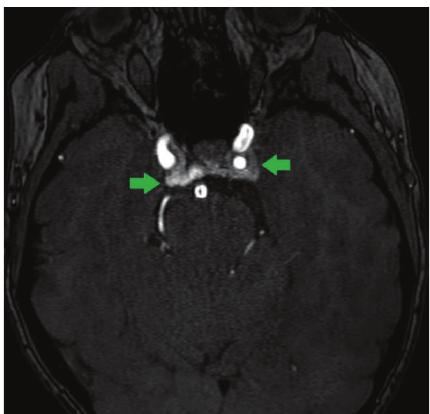
Figure 3: Axial head MRA image demonstrating flow-related contrast from the internal carotid arteries entering the cavernous sinuses (arrows), suggesting bilateral carotid-cavernous